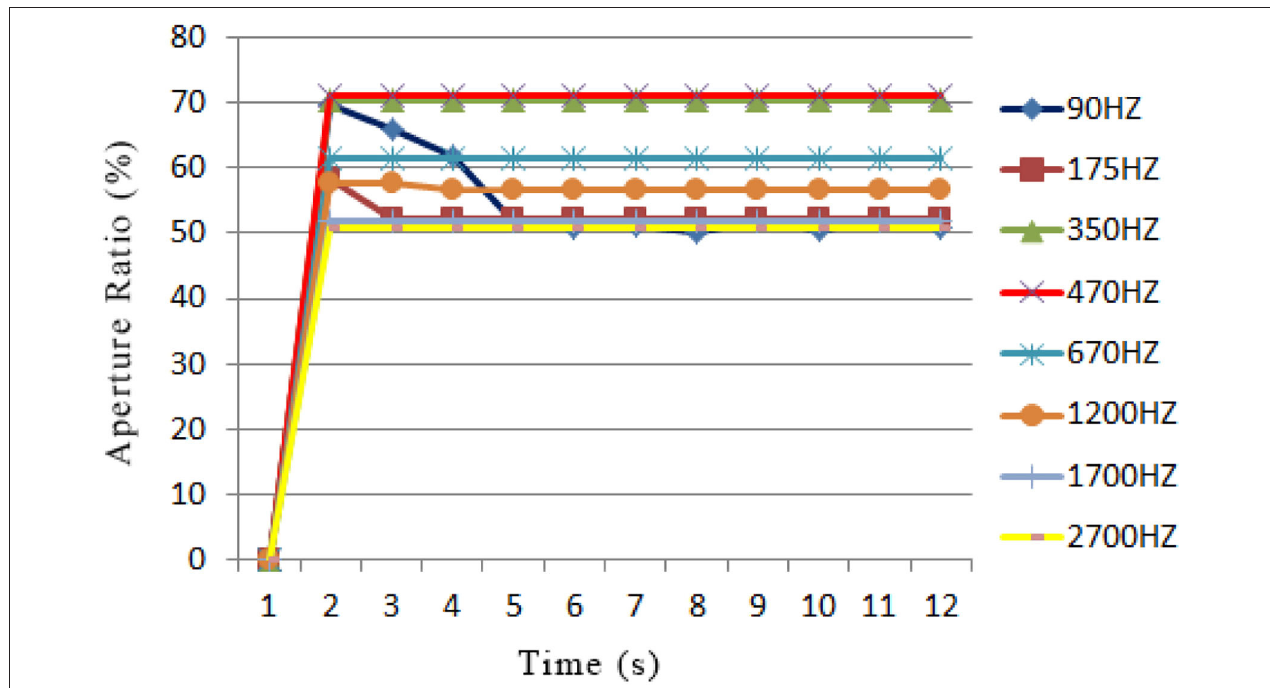
FIGURE 8 | The relationship between time and aperture ratio when an EWD was driven by a 30V AC driving voltage at different frequencies. The smoothness of curves represented the oil stability. The 470Hz AC driving voltage had the largest aperture ratio and most stable aperture ratio.